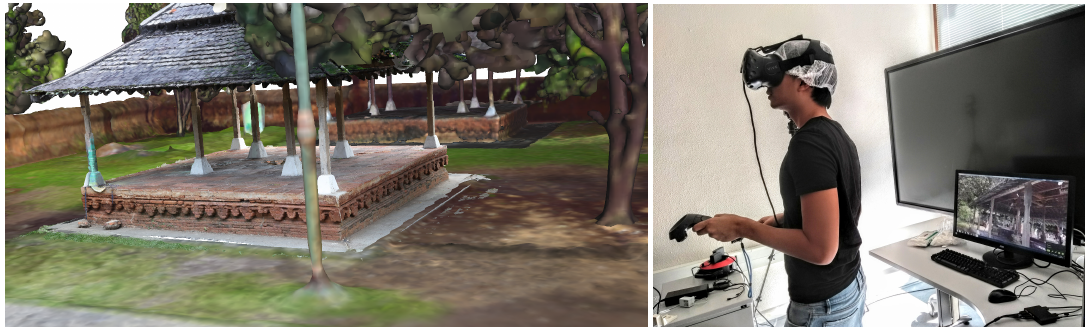
Figure 13. The virtual visit environment developed for the Siti Inggil area. To the left, the combined 3D mesh models from various scale steps. Notice that the 3D model of the pavilion is at a higher resolution than the ground or tree beside it. To the right, a virtual visit of the same area using VR